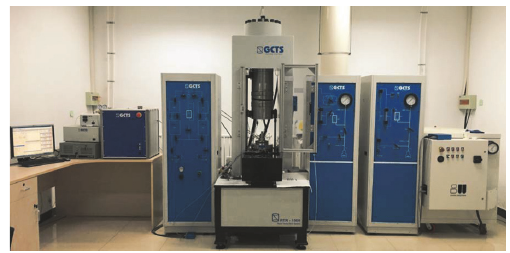
Figure 4: RTR-1500 HTHP triaxial rock testing system.